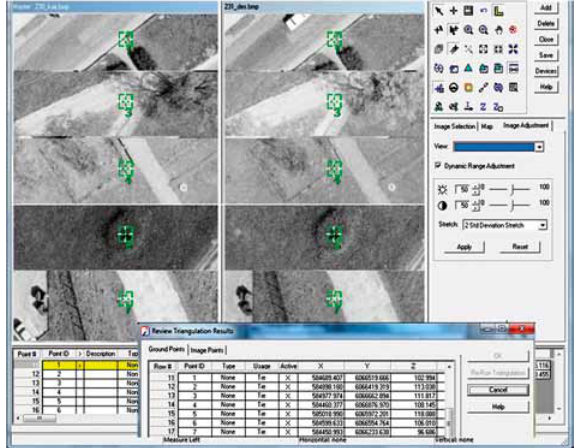
Fig. 5. Fragment of points selected for coordinates checking Table 1. Distribution of point numbers regarding the defined